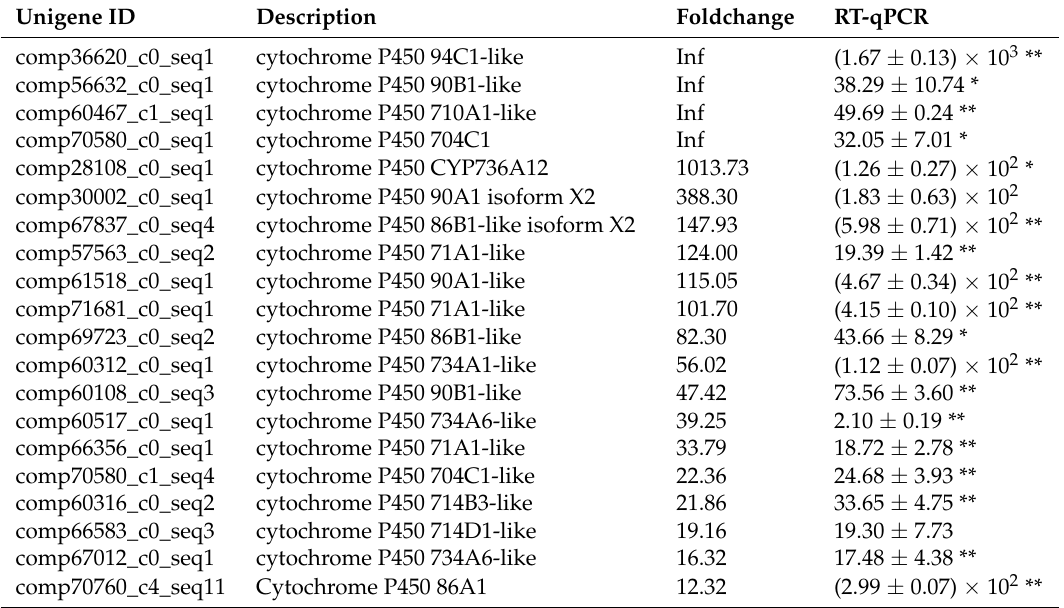
Table 4. Validation of the expression levels of CYP450 unigenes by using RT-qPCR Unigene ID